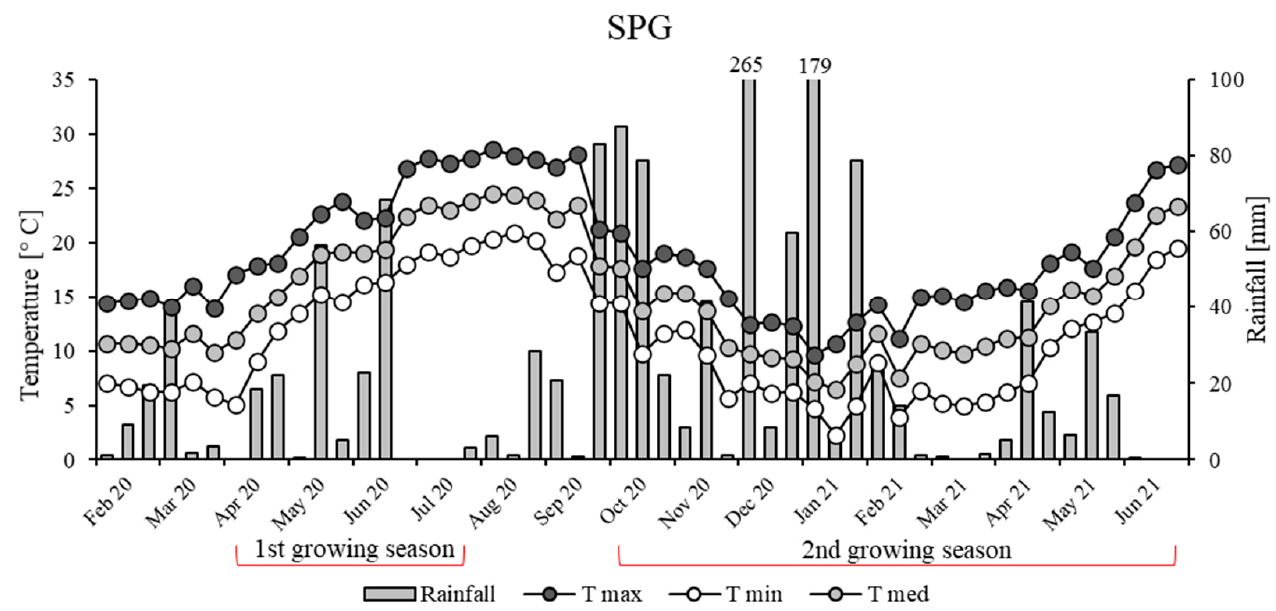
Figure 2. Monthly rainfall and mean, minimum, and maximum temperatures for the entire trial period at San Piero a Grado (SPG), Pisa.